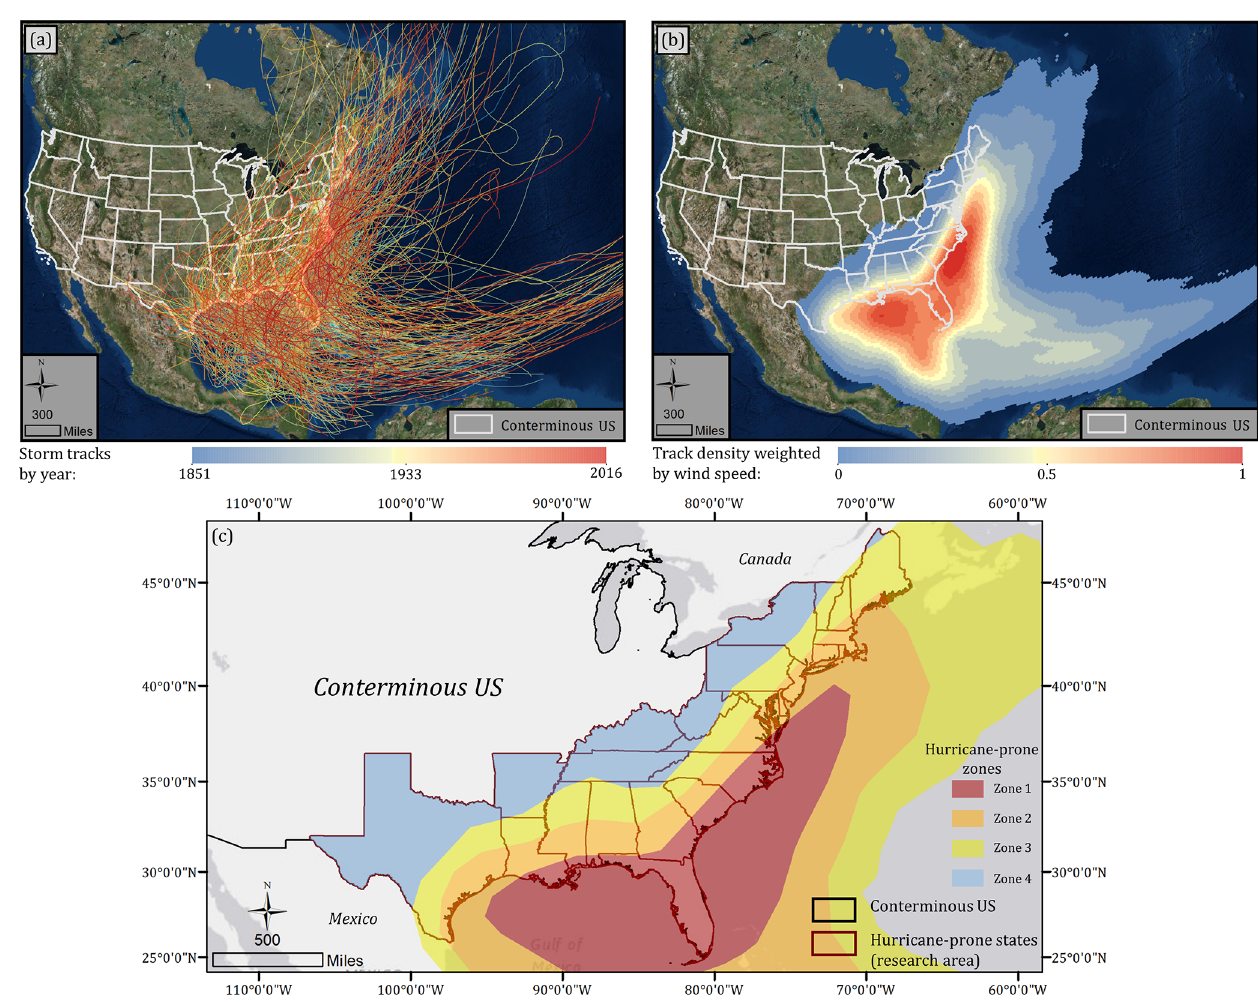
Figure 2. (a) Historical storm tracks from the North Atlantic Basin; (b) normalized storm tracks density weighted by wind speed; (c) hurricane-prone zones: Zone 4 (with track density 0–0.2), Zone 3 (0.2–0.5), Zone 2 (0.5–0.7), and Zone 1 (0.7–1.0). Basemap sources: Esri, HERE, Garmin, OpenStreetMap contributors, DigitalGlobe, GeoEye, i-cubed, USDA FSA, USGS, AEX, Getmapping, Aerogrid, IGN, IGP, swisstopo, and the GIS User Community. © OpenStreetMap contributors 2019. Distributed under a Creative Commons BY-SA